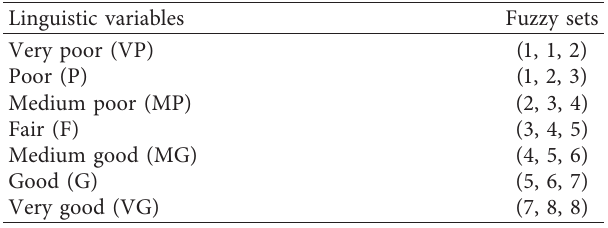
Table 2: Fuzzy sets corresponding to linguistic levels used to assess the attributes every time to construct the FD m ∗ n